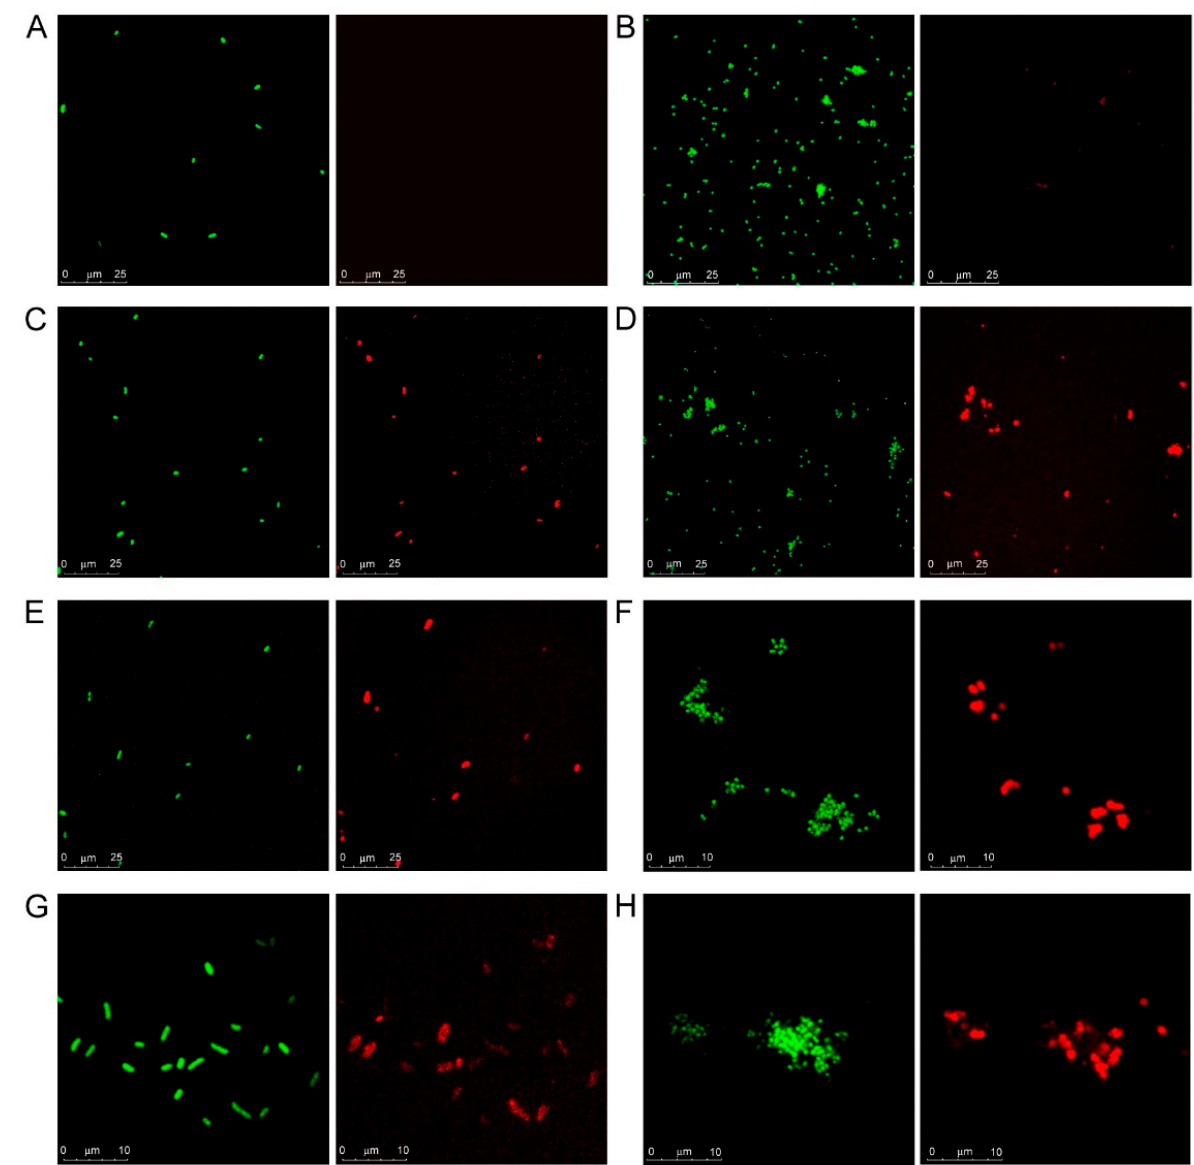
Figure 2. Confocal microscopy analysis of galectin binding to Kpn and NTHi cells. Suspensions of SYTO-13-labelled Kpn (panels A , C , E , G ) and NTHi (panels B , D , F , H ) cells at OD 600 = 0.5 were incubated with 12 µ g/mL of Gal-1 ( A , B ), Gal-3 ( C , D ), Gal-4 ( E , F ) or Gal-8 ( G , H ) and bound galectins were detected using the same protocol used in the microarray-binding assays, with incubation with AF647-streptavidin as final step. Green: SYTO-13 signals. Red: AF647 signals. For each image, scale bars are shown.